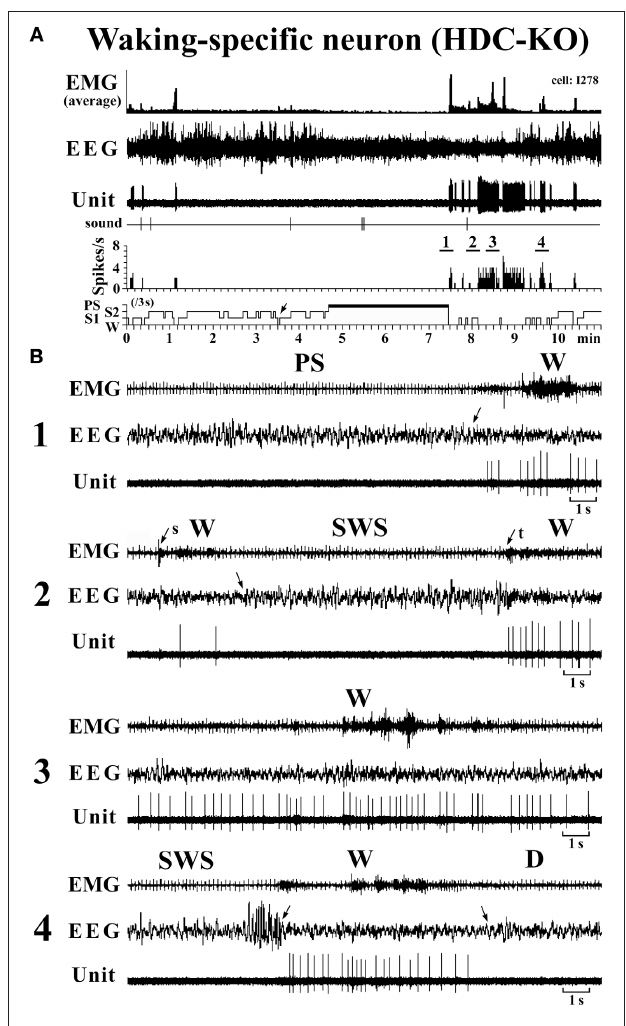
Figure 7 | Activity of a VTM W-specific neuron recorded in a HDC-KO mouse. The unlabeled arrows indicate the state transitions, while the arrows with “s” or “t” indicate W elicited by an sound stimulus or touching the tail with a soft brush. The four traces in (B) are from the periods indicated by the bar under, respectively, “1”, “2”, “3” and “4” in (A)